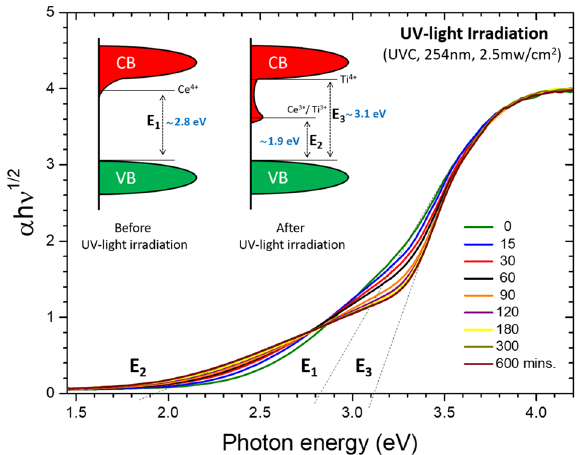
Figure 4. Plot of (α hv ) 1 / 2 vs.hv deduced from the UV–Vis diffuse reflectance spectra of UV-light irradiated sample with various irradiation times.